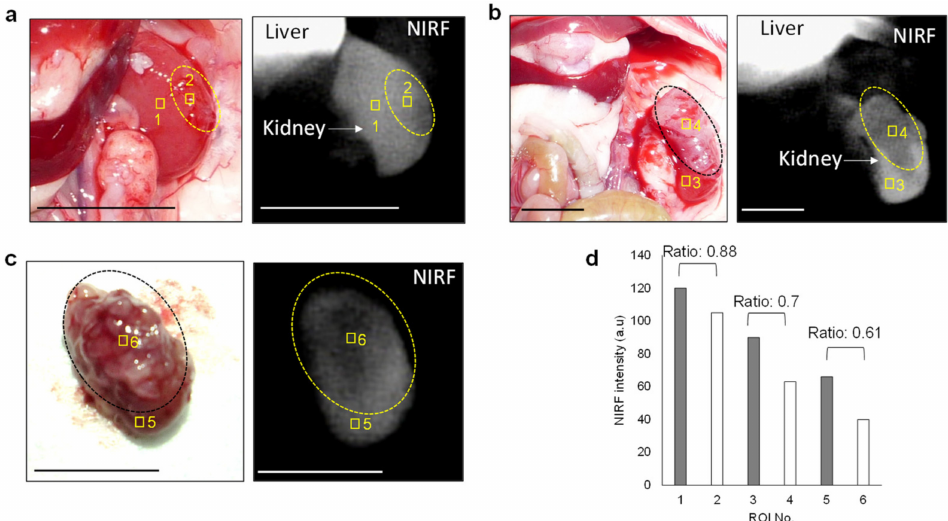
Figure 7. In vivo and ex vivo near-infrared fluorescence (NIRF) imaging of cancerous kidneys using indocyanine green (ICG). Images were obtained at 10 min after the intravenous administration of ICG (120 nmol/kg body weight) in mice. ( d ) Mean NIRF intensity in ROI shown in squares in images ( a – c ). Cancer tissues are in the dotted circles. NIRF is displayed in white. Scale bar = 10